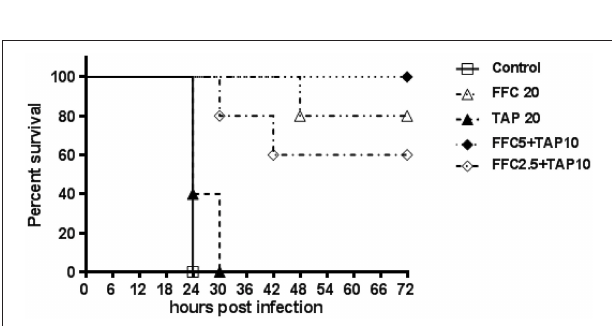
FIGURE 3 | Florfenicol (FFC)/thiamphenicol (TAP) combination protects broiler chickens from P. multocida infection. Five groups of five broiler chickens challenged with 10 3 CFU of P. multocida (101-035) and the mortality was recorded every 6 h until 72 h post